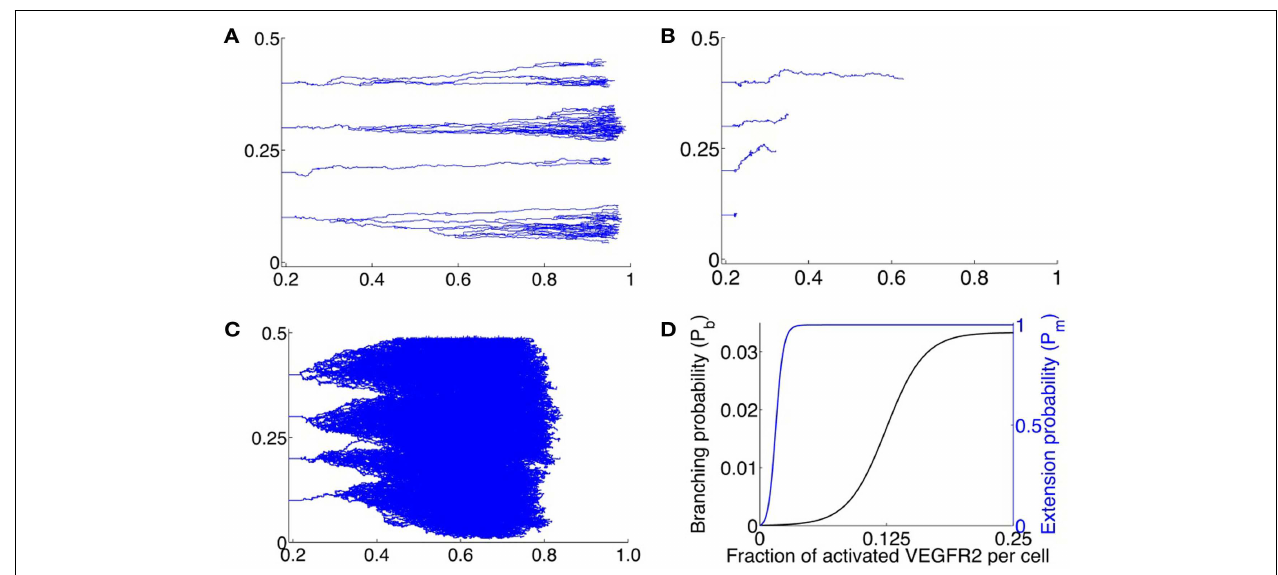
proliferation or polarization of the tip cell, leading to a poorly developed and stunted vasculature that does not reach theVEGF source within the time frame of simulations (3days). (C) C 0 = 0.030pg/lattice volume. Due to a high VEGF concentration, over-stimulation of endothelial cells occurs, and extensive branching, anastomoses and lateral movement of the tip cell is observed. Due to excessive lateral movement, the vasculature that does not reach theVEGF source within the time frame of simulations (3days). (D) Assumed branching probability P b of the migrating tip cell (black curve), and assumed extension probability P m of the capillary (blue curve), expressed as functions of total fraction of activatedVEGFR2 per